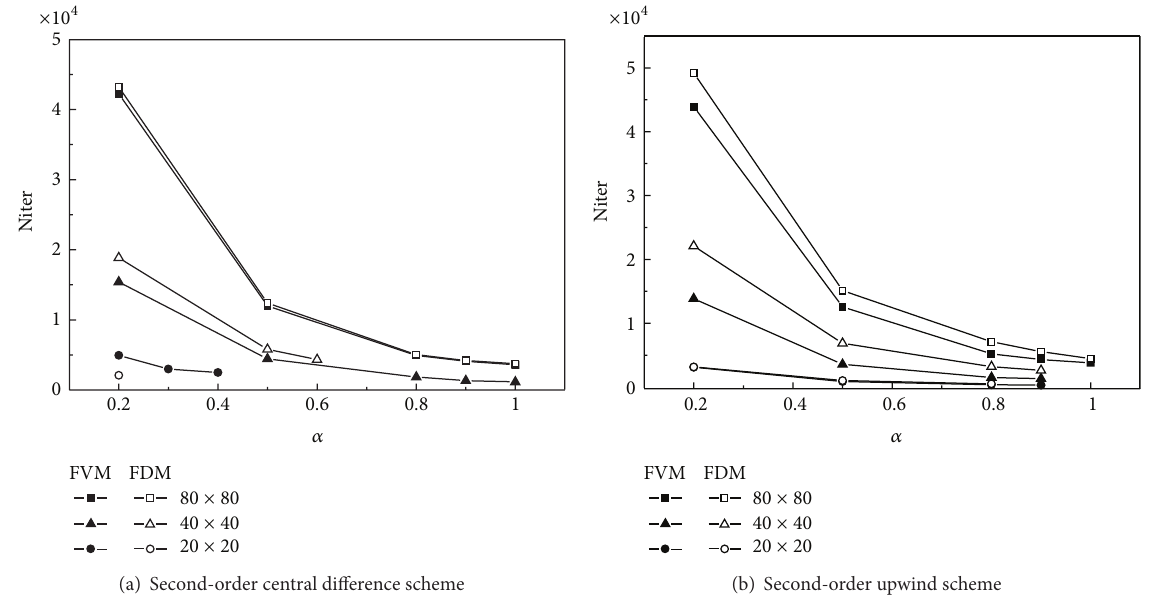
Figure 10: Comparison of the robustness of lid-driven flow with variant